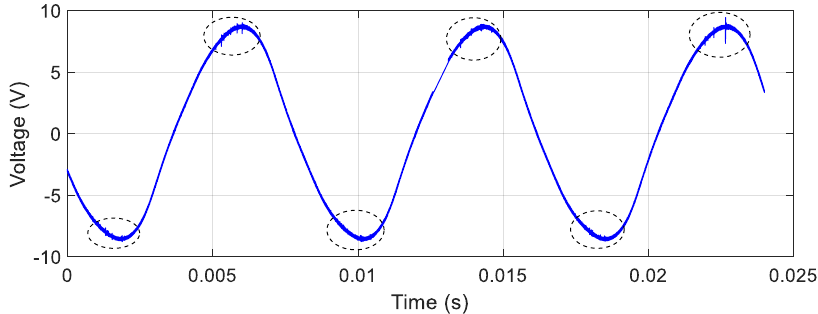
Figure 22. Signal with PD acquired from the test tap of bushing of phase A.